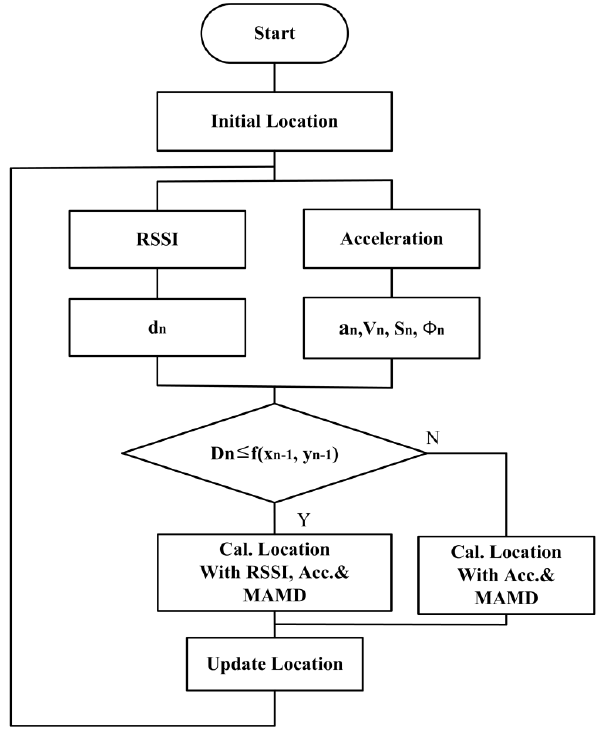
Figure 5. Flow of positioning with RSSI and acceleration.